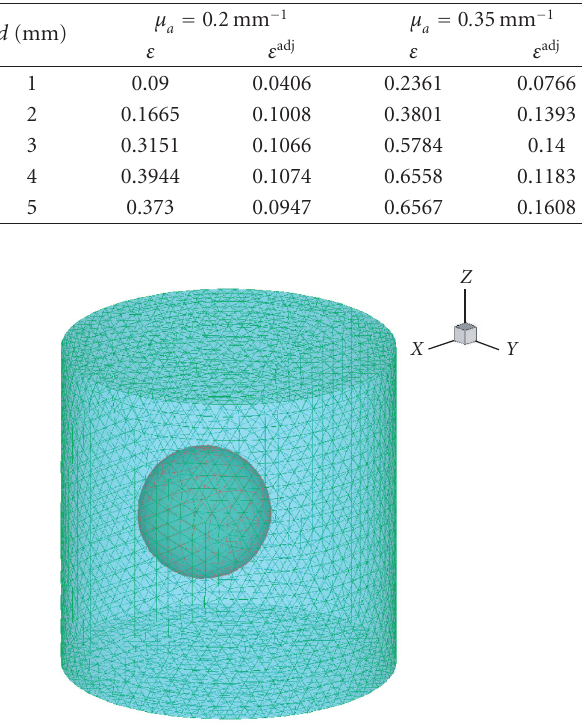
Figure 4: The finite element model of the heterogeneous phantom.